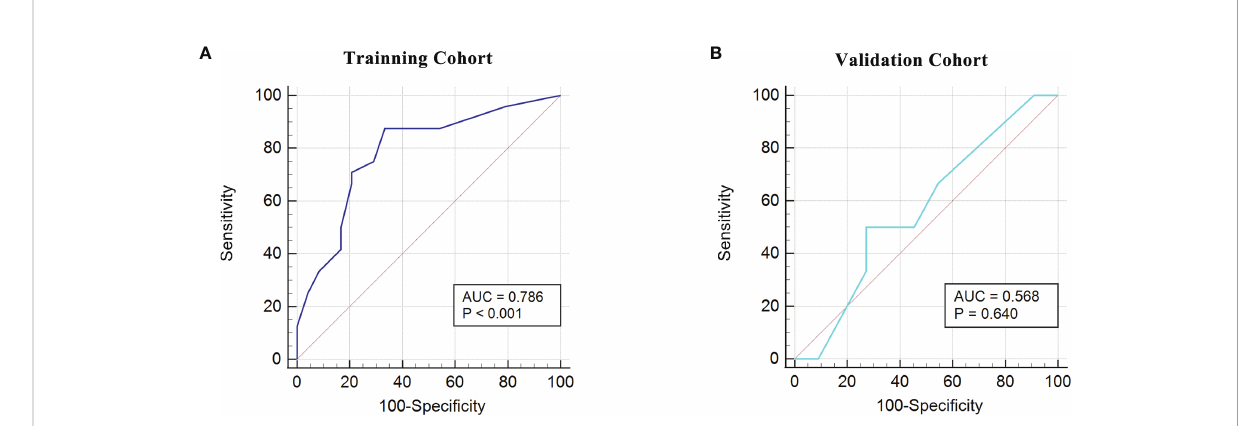
TABLE 2 Identi fi ed candidate peptide biomarkers.